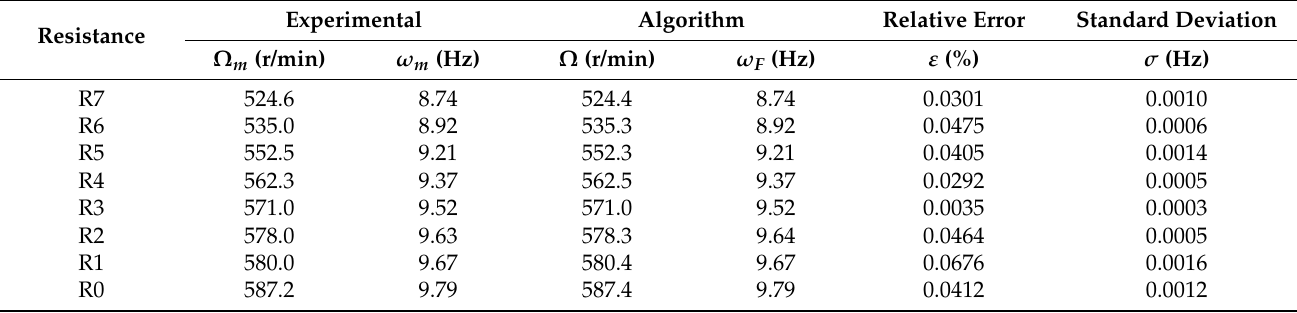
Table 10. DC generator coupled to the motor shaft: estimated speeds and frequencies, relative errors, and standard deviations for load tests at 10 Hz.